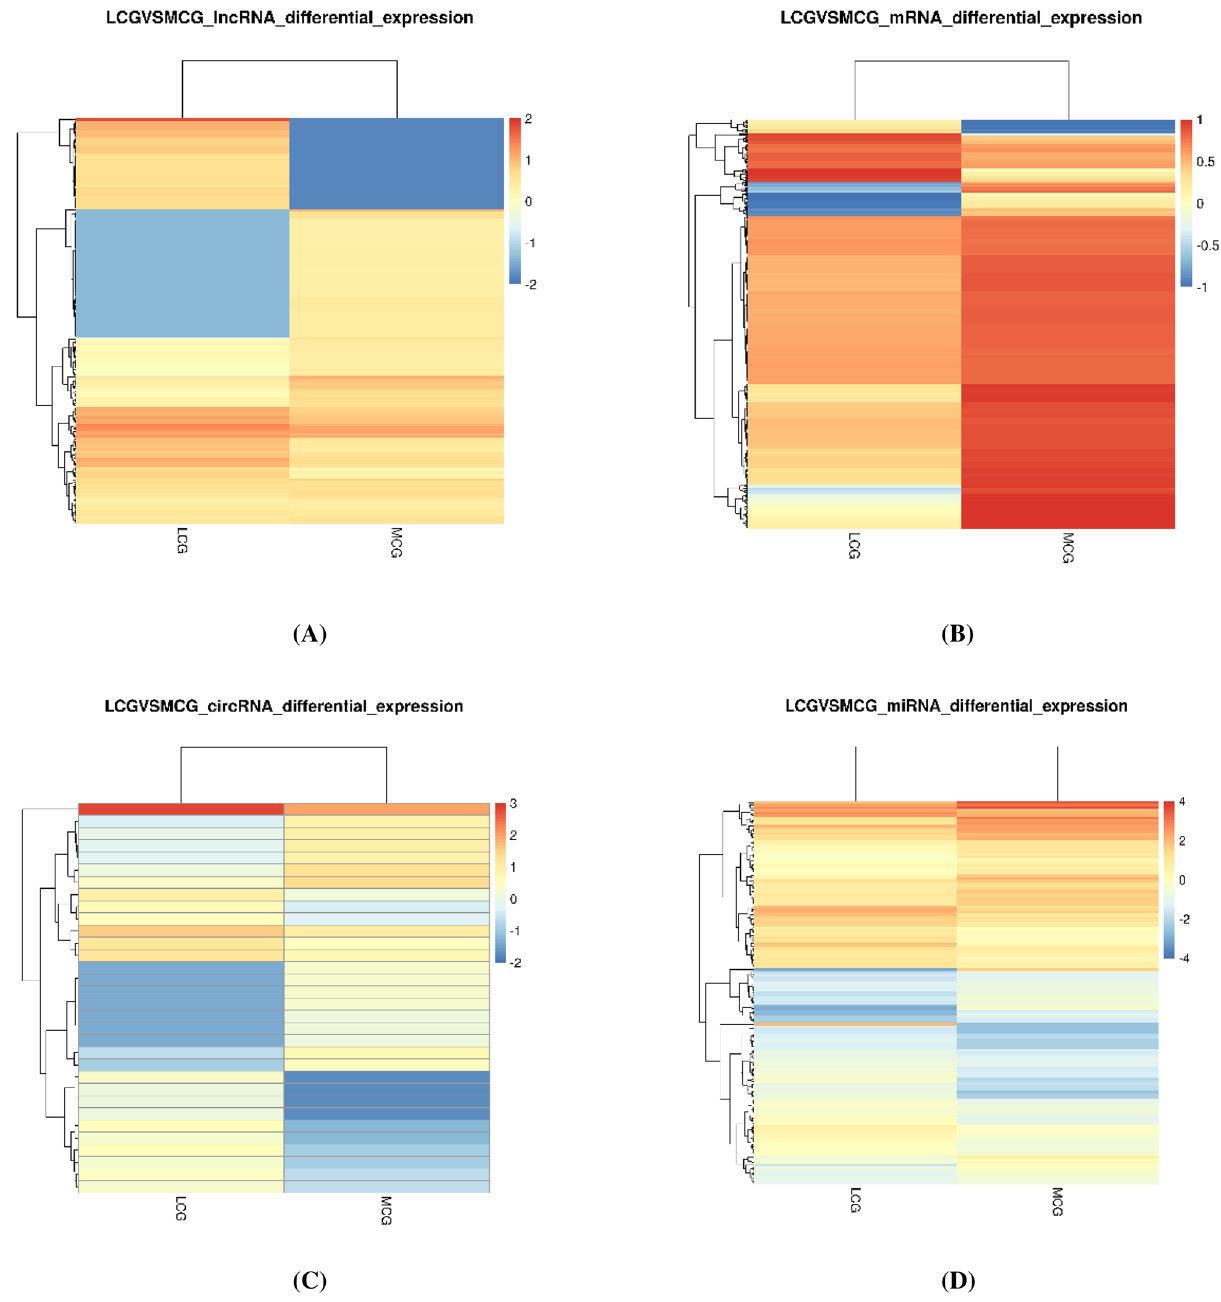
Figure 1. Heatmap of DElncRNAs, mRNAs, circRNAs and miRNAs between LCG and MCG. ( A ) Heatmap of DElncRNAs. ( B ) Heatmap of DEmRNAs. ( C ) Heatmap of DEcircRNAs. ( D ) Heatmap of